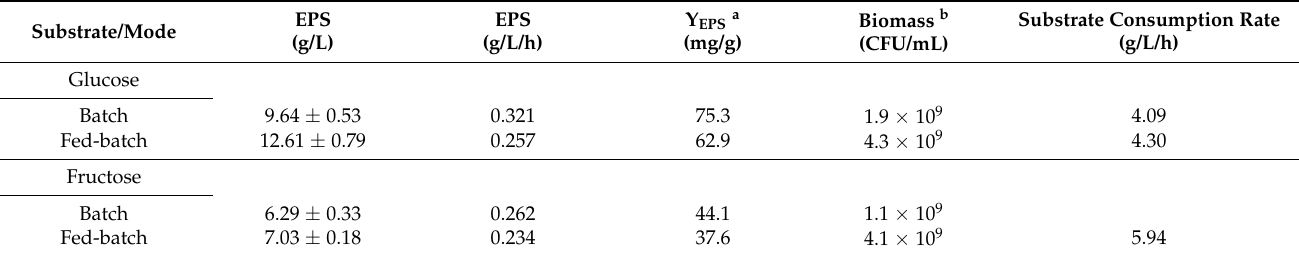
Figure 4. Time profiles of biomass formation and EPS production by B. licheniformis 24 during batch and fed-batch fermentation in fermenter Biostat ® Aplus, working volume 1 L. ( a ) EPS1 production during batch fermentation of glucose; ( b ) EPS2 production during batch fermentation of fructose; ( c ) EPS1 production during fed-batch fermentation of glucose; ( d ) EPS2 production during fed-batch fermentation of fructose. The starting sugar concentrations were 200 g/L; sterile glucose or fructose was added during the fed-processes — 125 mL glucose (700 g/L) and 210 mL fructose (870 g/L). The mean values from two independent batch and fed-batch processes are presented. Table 1. Comparison of EPS produced by B. licheniformis strains in batch and fed-batch processes from glucose and fructose. The average values of two distinct experiments are presented.